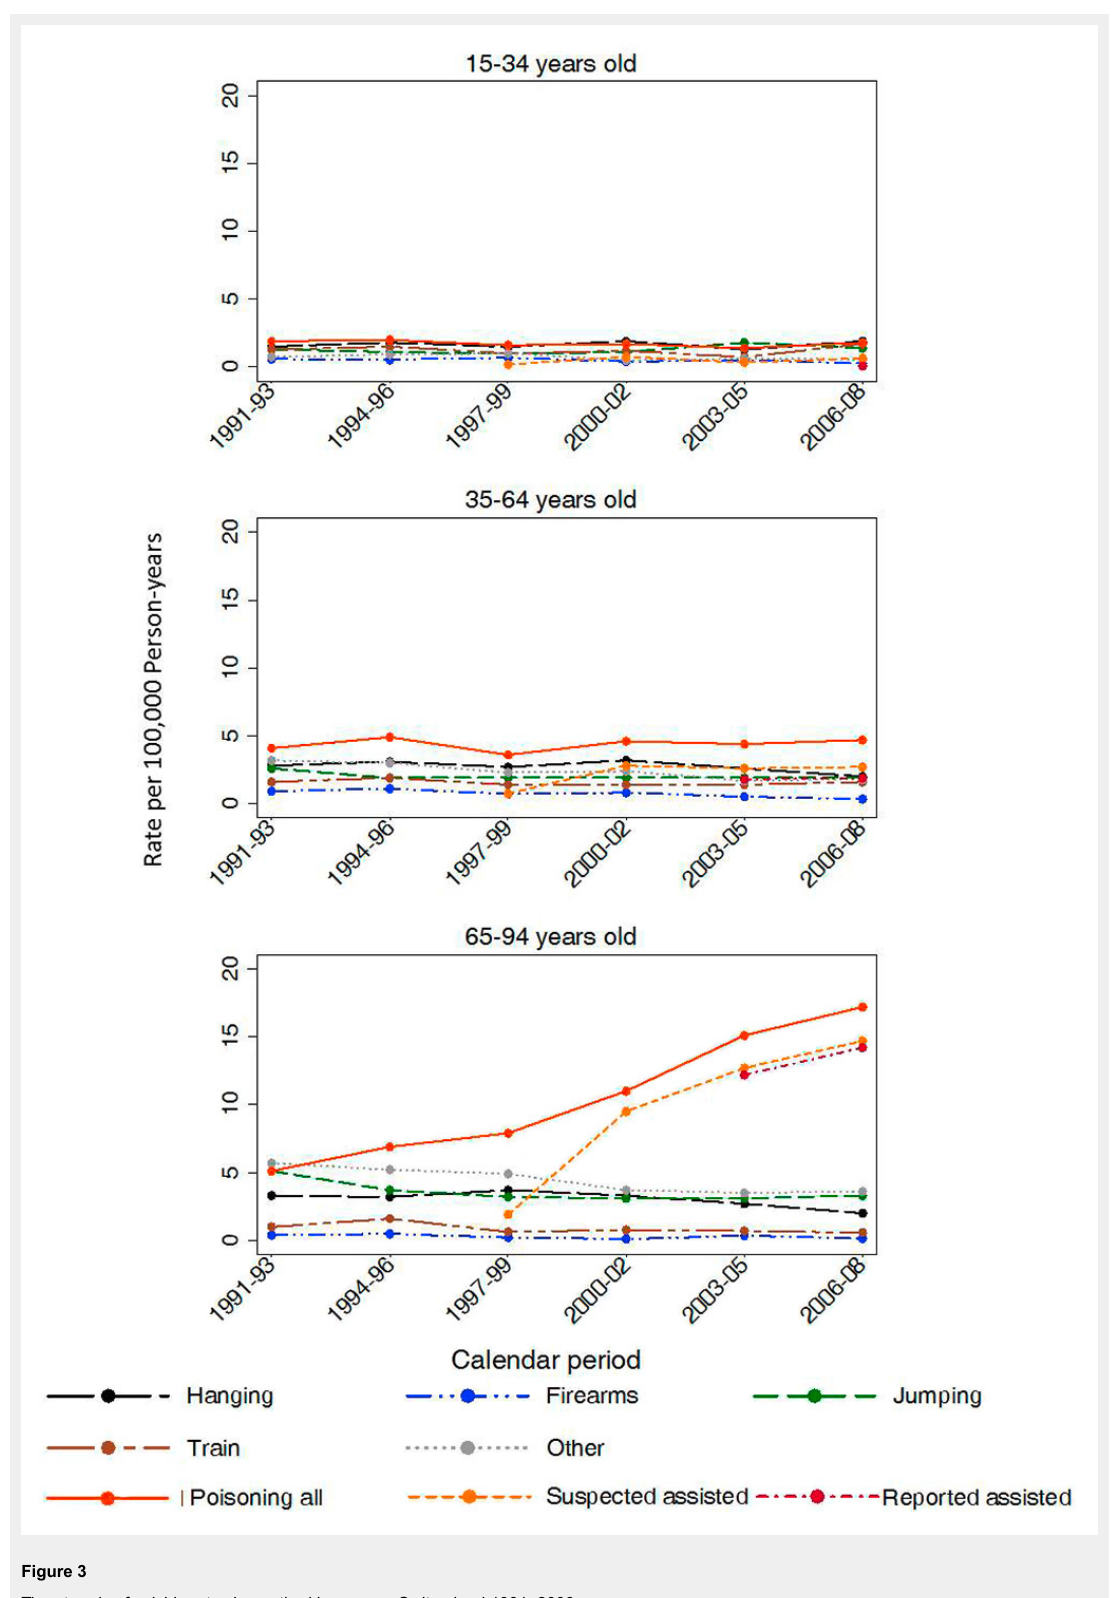
Figure 3 Time-trends of suicide rates by method in women; Switzerland